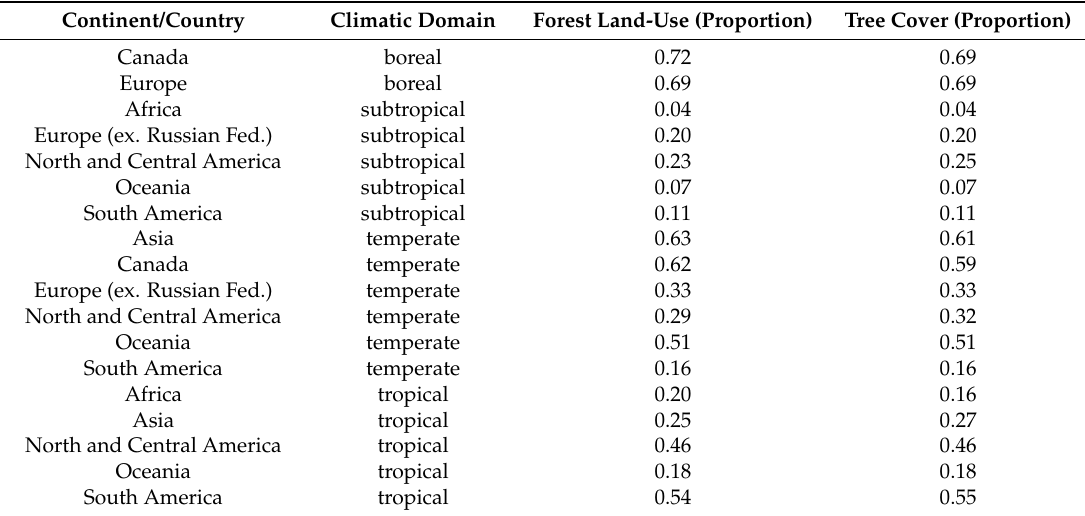
North and Central America tropical 0.46 tropical 0.18 0.18 South America tropical 0.54